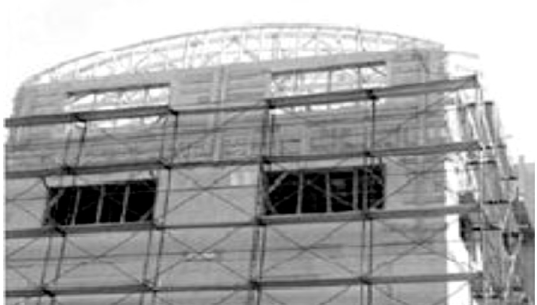
Fig. 2. The building ’ s foundation.